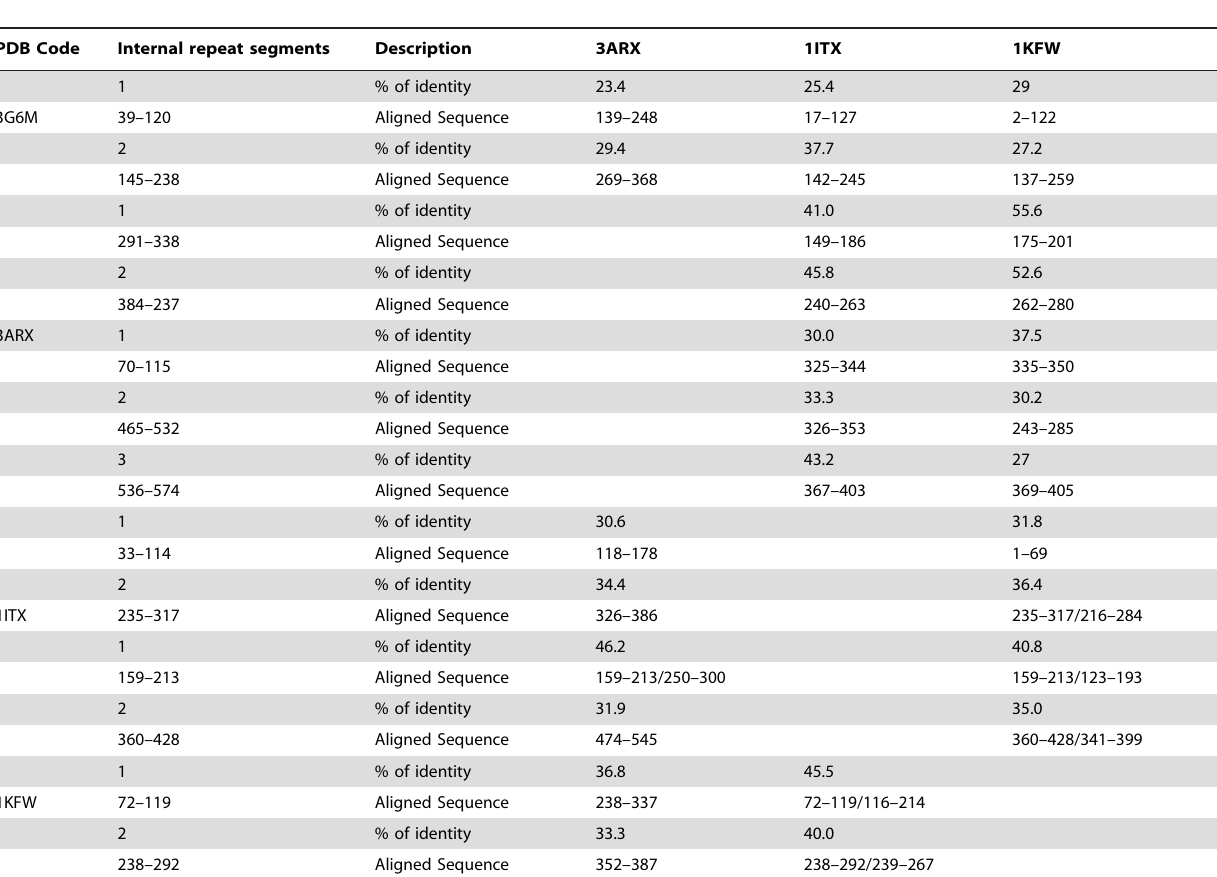
Table 3. Inter – repeat % identity across different TIM fold Chitinase sequences.